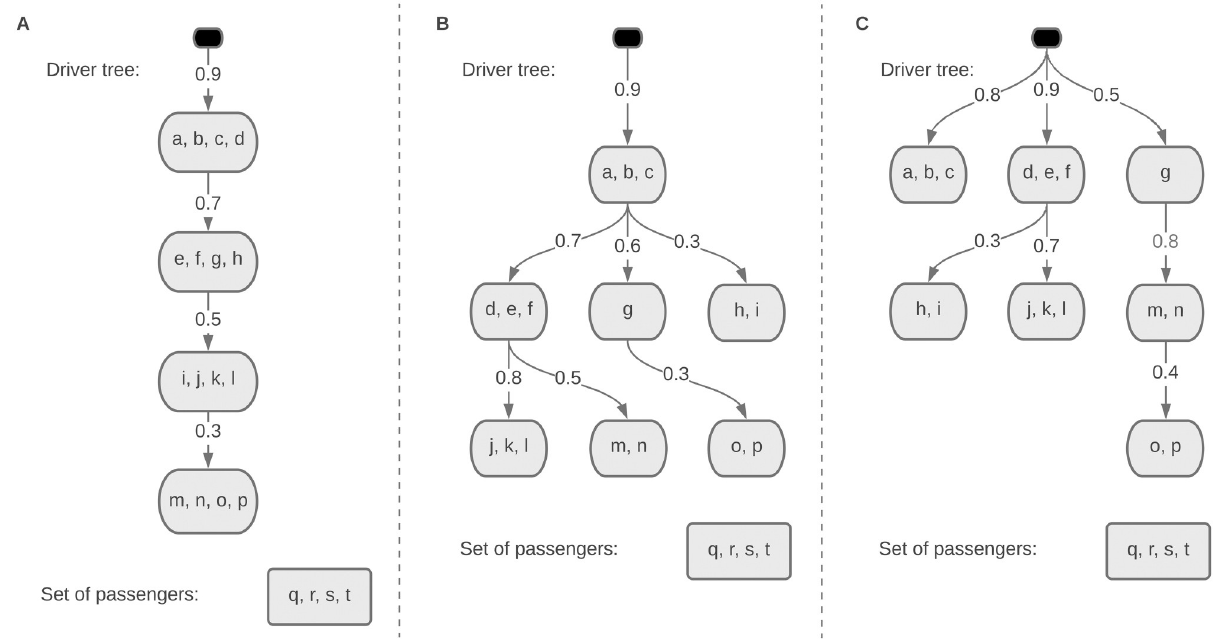
Fig 4. Generative progression model for the synthetic data experiments with A . linear model B . single-seeded tree model C . multi-seeded tree model.